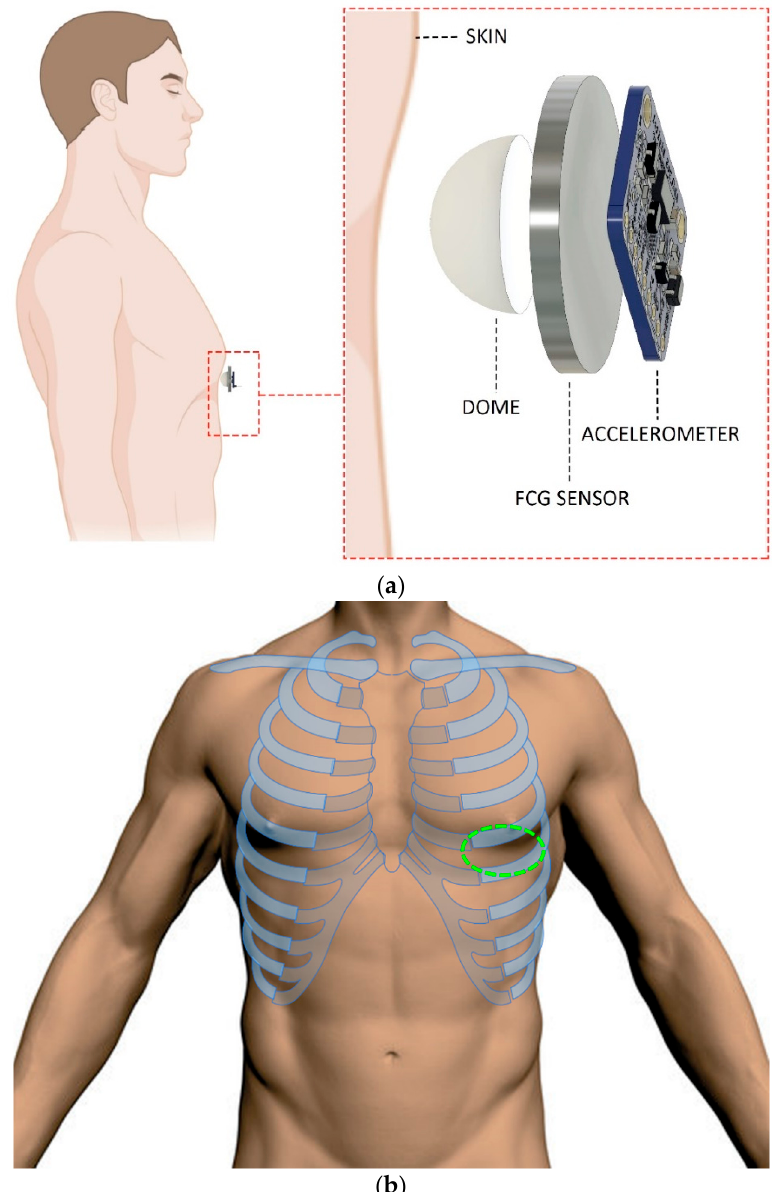
Figure 1. ( a ) Lateral view of sensors assembly applied on the chest of a subject; ( b ) frontal view of sensors positioning area on the chest (green dashed line).